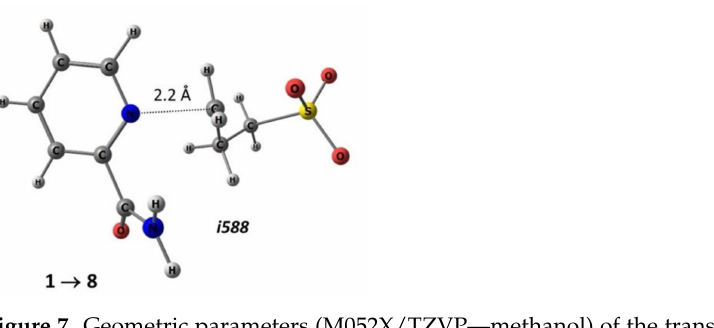
Figure 7. Geometric parameters (M052X/TZVP—methanol) of the transition state of the reaction of the nucleophilic addition of 1,3-propanesultone to substrate 1 with the formation of product 8 : i588—imaginary frequency in the matrix of second